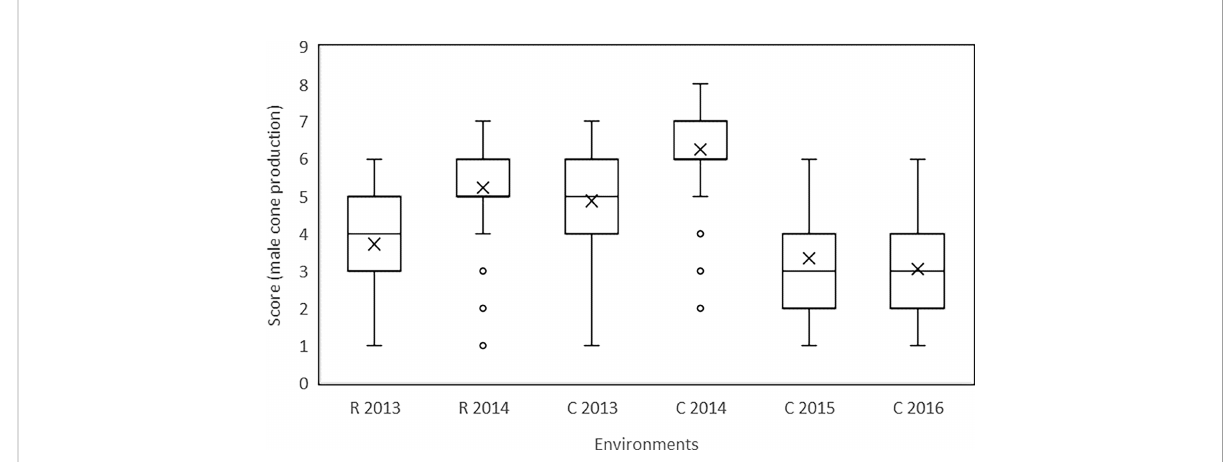
FIGURE 2 Data referred to the scores recorded for male cone production of individual ramets of the surveyed common cypress clones in the two sites (R: Roselle; C: Cannara) and in various years are reported as box plot. The ends of the box are the fi rst and third quartiles, the line inside the box is the median value (the mean value is also reported as x), the two vertical lines outside the box extend to the highest and lowest observations; data not included between 1.5 IQR (outliers) are plotted with a